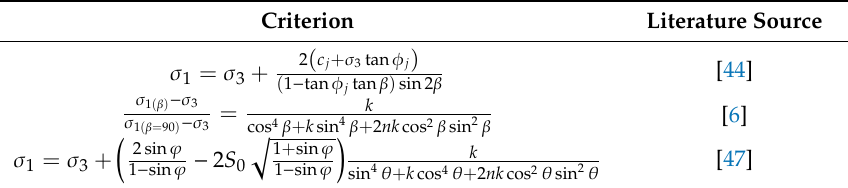
Table 1. Failure criteria for the bedding fractures proposed by di ff erent